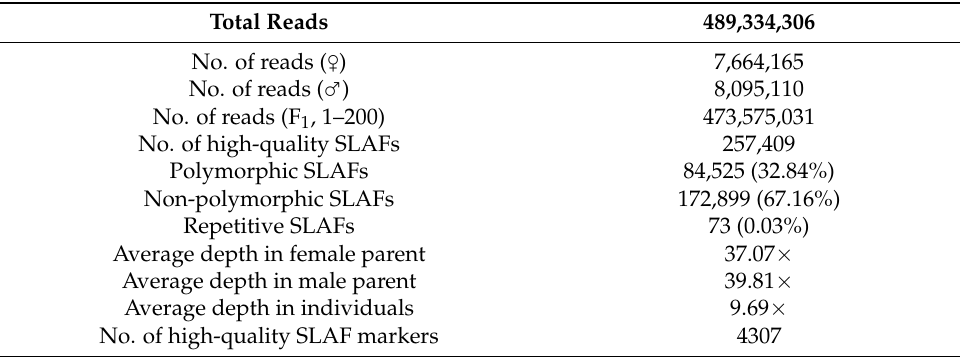
Table 1. SLAF-seq data summary for the parents and F 1 population of